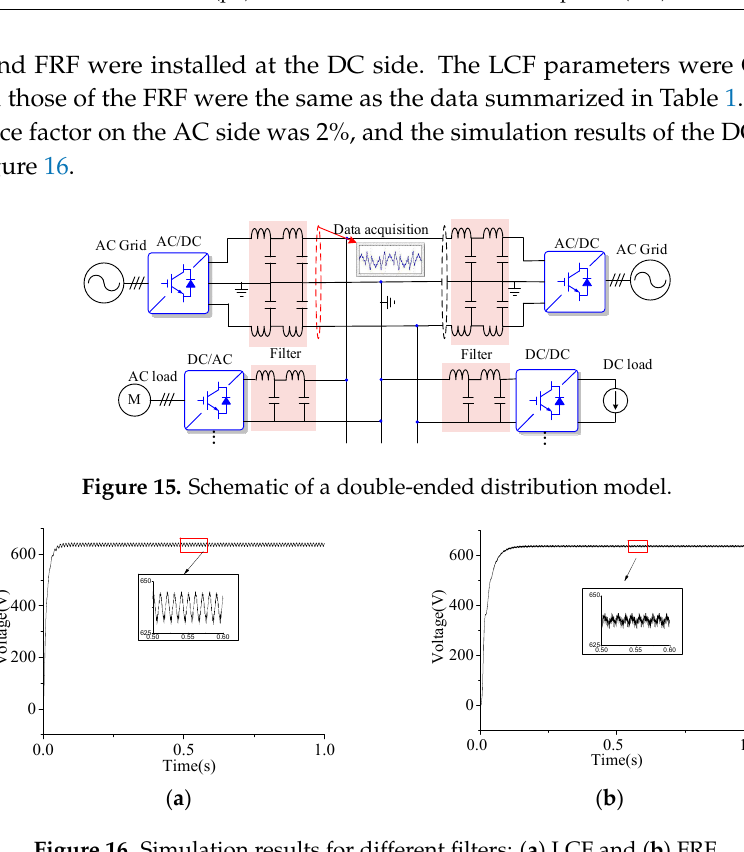
Figure 16. Simulation results for different filters: ( a ) LCF and ( b )